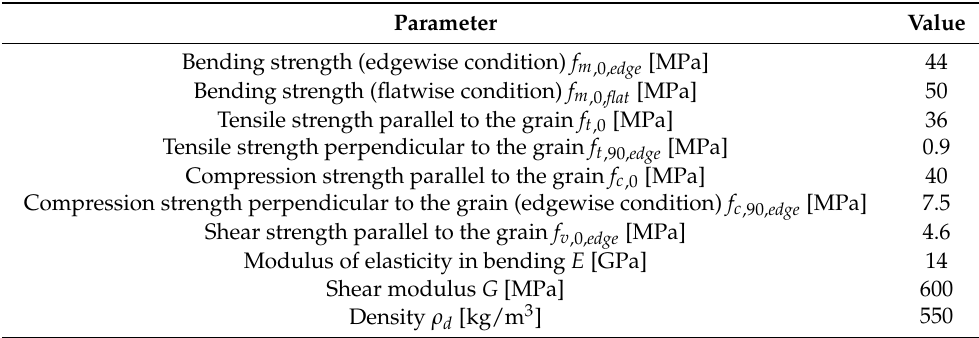
Table 1. Mechanical and physical properties of laminated veneer lumber (exposed by manufacturer)